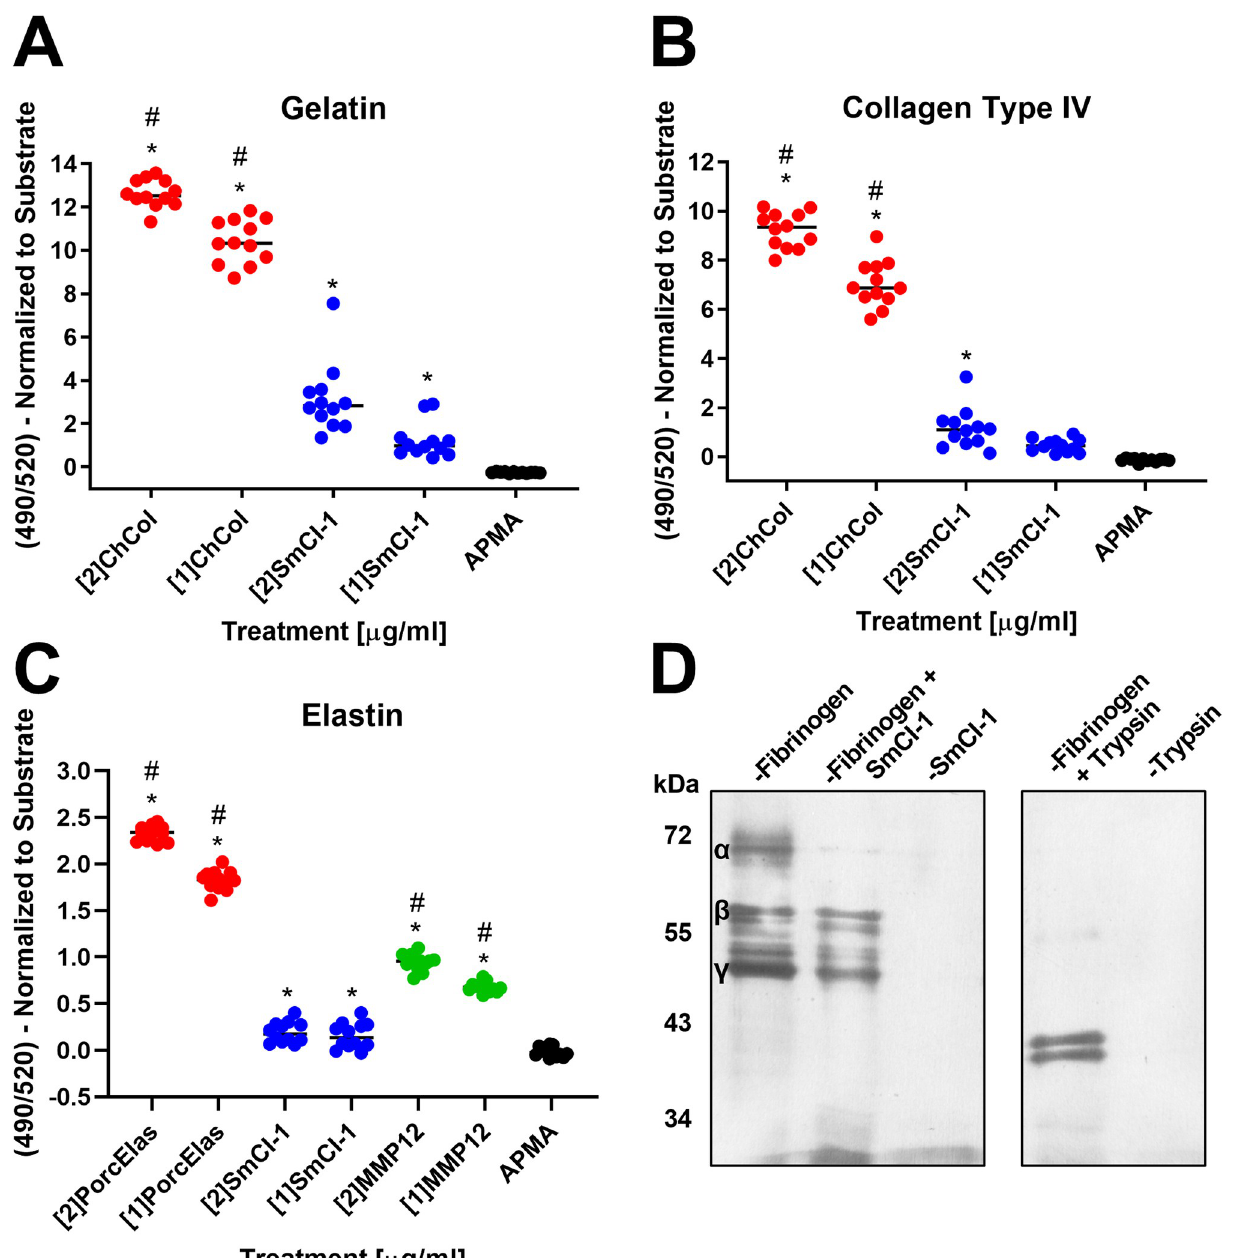
Fig 3. SmCI-1 weakly cleaves key host ECM components. Recombinant SmCI-1 cleaves gelatin (A), collagen type IV (B), and elastin (C). In all cases, known positive controls for collagen type 4 and gelatin cleavage ( C . histolytica collagenase) and elastin (porcine elastase and human MMP12) displayed higher levels of cleavage. Differences from the APMA vehicle control are denoted using ( � ) and samples with significantly higher cleavage activity than rSmCI-1 are denoted using (#). (D) Silver stain demonstrating the capacity of trypsin to cleave all three subunits of fibrinogen, and that rSmCI-1 can cleave the alpha subunit of fibrinogen only (n =